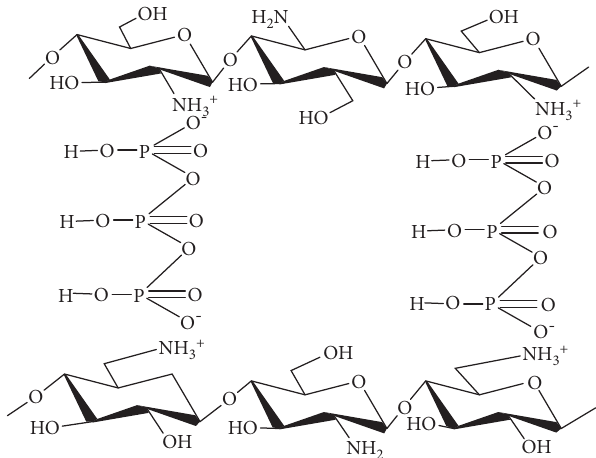
Figure 3: Structure of microspheres crosslinked by chitosan and sodium tripolyphosphate